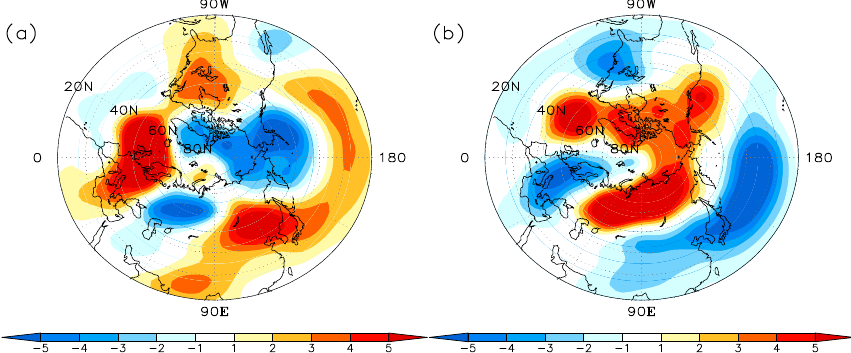
Figure 7. Composite field of the geopotential height anomaly at 500 hPa (shading, units: dgpm) in January of the higher haze-fog years ( a ) and lower haze-fog years ( b ).